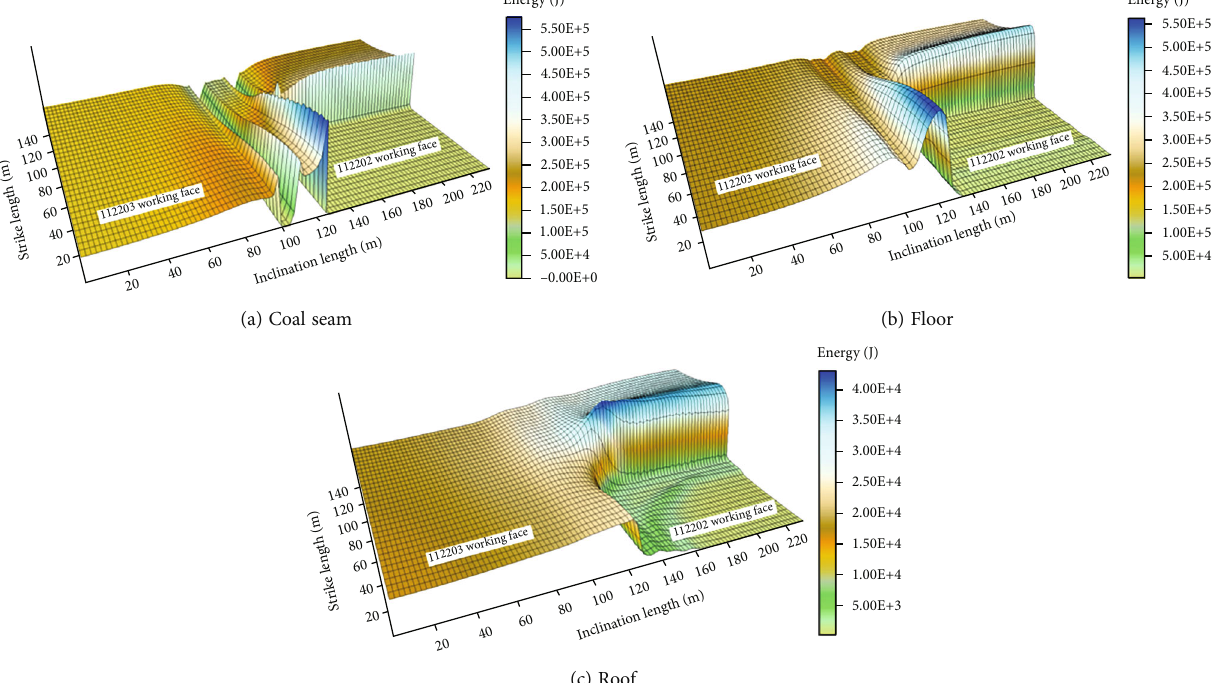
Figure 6: Energy distribution characteristics of the surrounding rock during primary